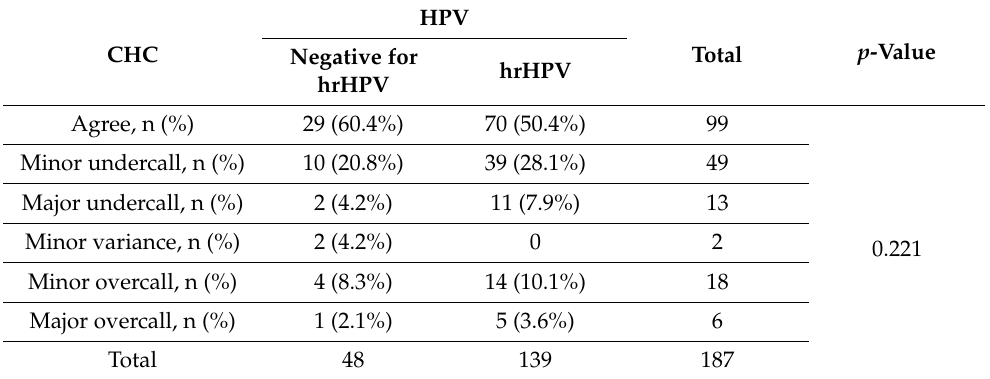
Table 2. HPV status in discrepancy cases.